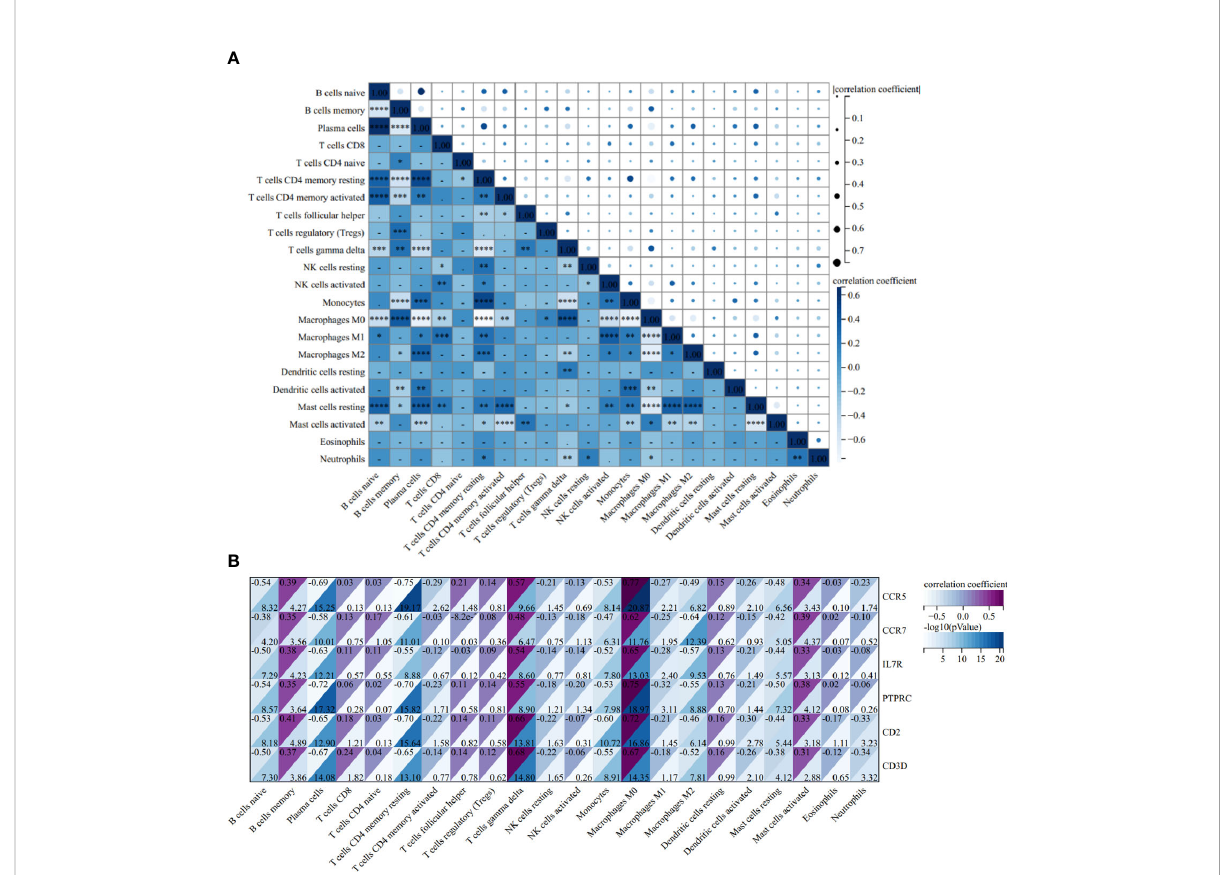
FIGURE 12 Correlation Analysis in AS. (A) Related heat maps of 22 immune cells in GSE100927. (B) Correlation heat map between hub genes and immune cells in GSE100927. *p < 0.05; **p < 0.01; ***p < 0.001, ****p <